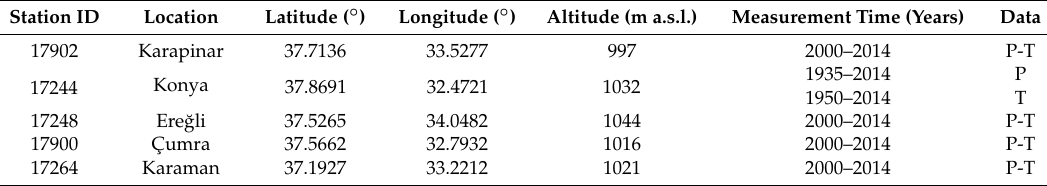
Table 4. Meteorological stations used for the analysis (for location see Figure